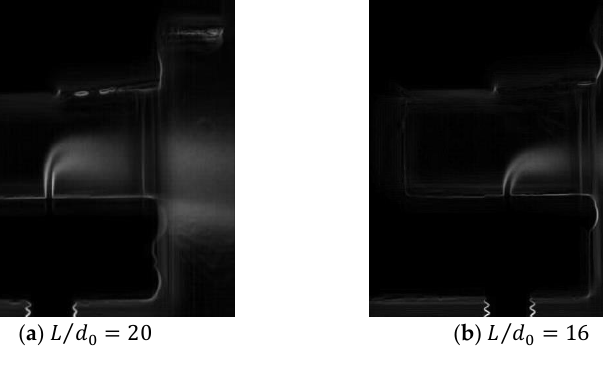
Figure 10. Density gradient magnitude images at various 𝐿 𝑑 0 ⁄ values for We a = 25 , We l = 179 , and 𝐻 𝑑 0 ⁄ = 10.